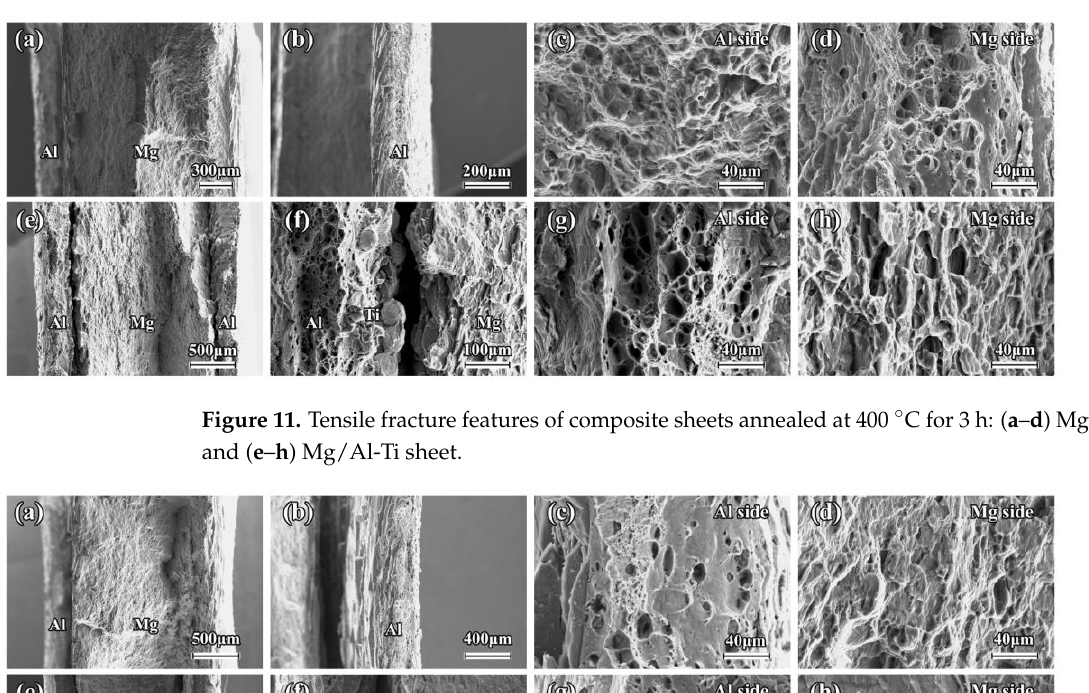
Figure 10. Tensile fracture features of as-rolled composite sheets: ( a – d ) Mg/Al sheet, and ( e – h ) Mg/Al-Ti sheet.